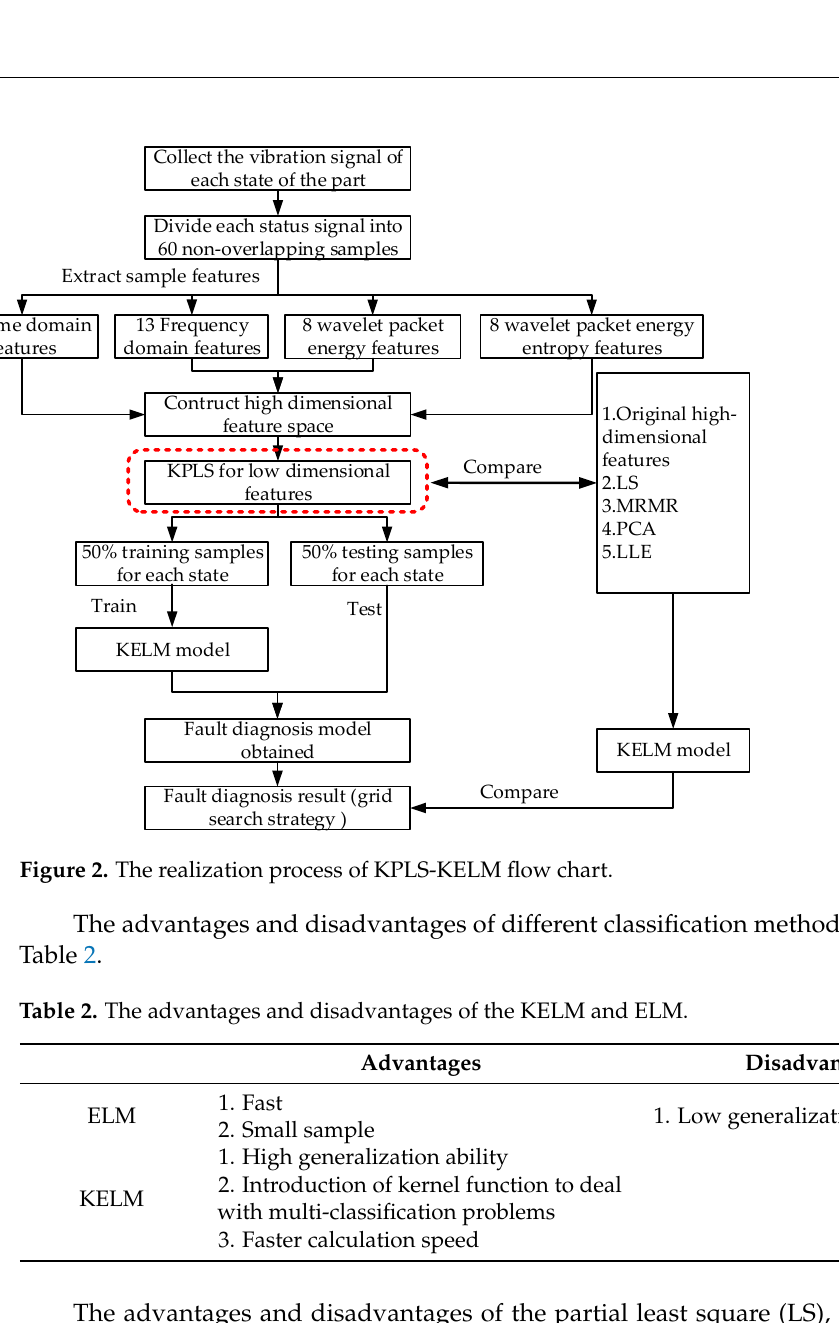
Table 3. The advantages and disadvantages of dimensionality reduction methods.